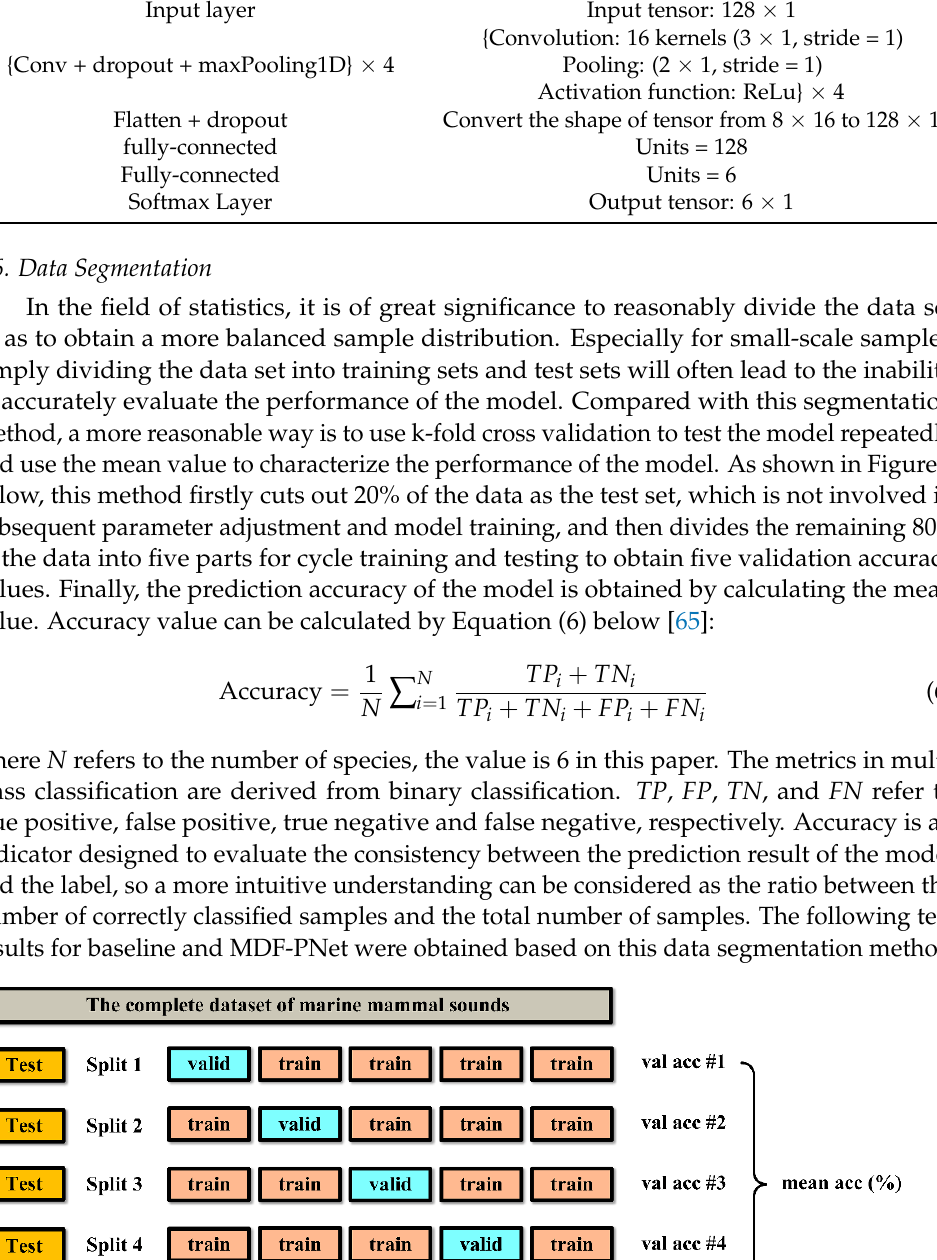
Table 2. The detailed parameters of used 1D-CNN.